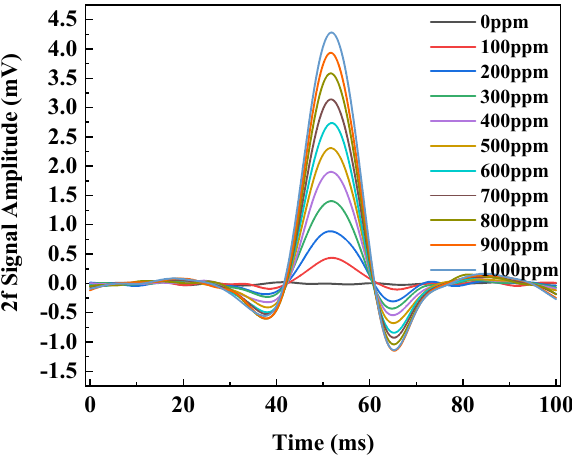
Figure 10. The observed 2 f signals in the C 2 H 2 concentration range of 0–1000 ppm.